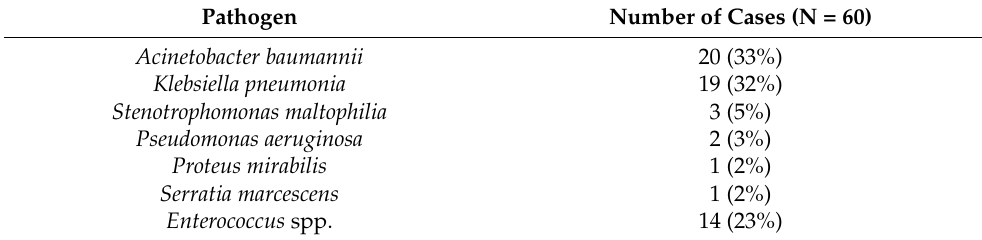
Table 4. Pathogens detected in blood stream